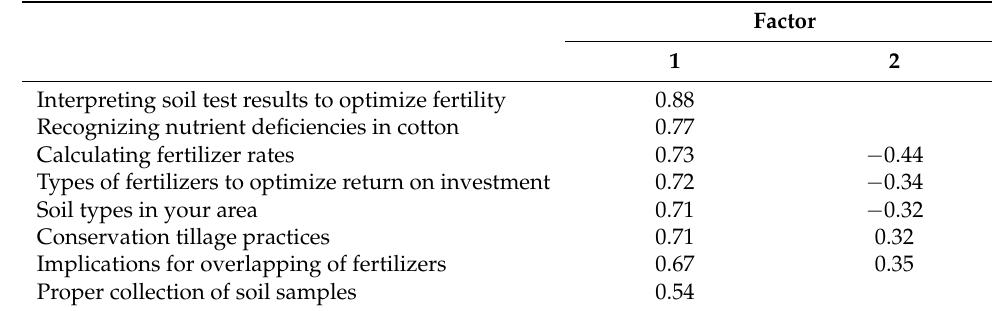
The importance of proficiencies of soil and nutrient management competencies were analyzed using a factor matrix. Factor one consisted of eight items with factor loadings ranging from 0.56 to 0.89 and explained 50.66% of the variance. Factor two consisted of three items with factor loadings ranging from − 0.40 to 0.67. and explained 64.50% of the variance (see Table